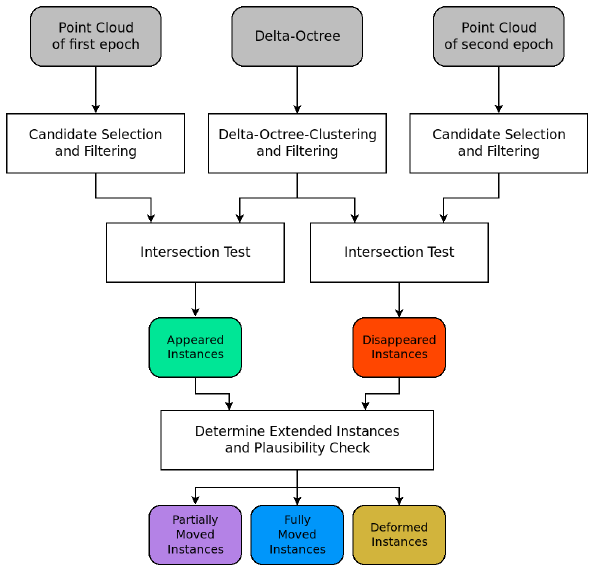
Figure 5. The individual sections of the change detection method presented in this